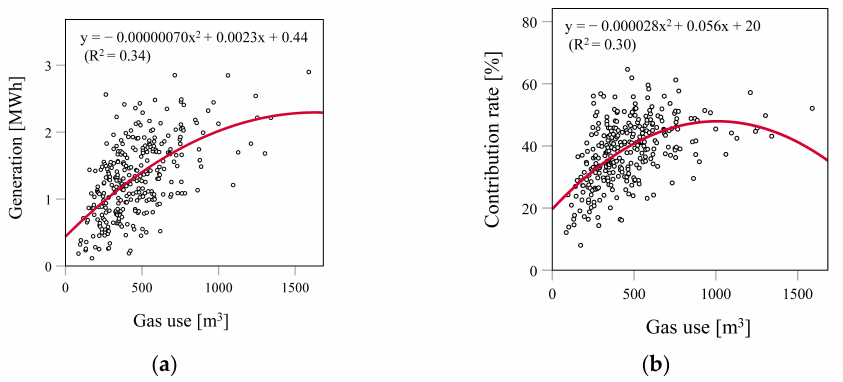
Figure 5. Relationship between the annual gas use (except for CGS) and the energy-saving effects of CGS in each household (n = 304): ( a ) generation; ( b ) contribution